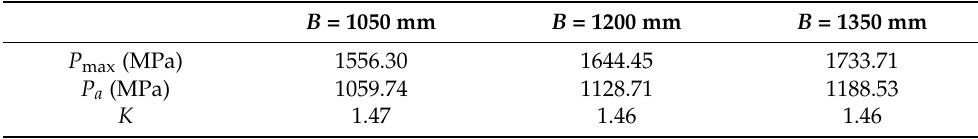
Figure 6. Contact pressure between the rolls at different rolling forces q ( S = 0 mm, B = 1200 mm). Table 2. The coefficient K at different strip widths B